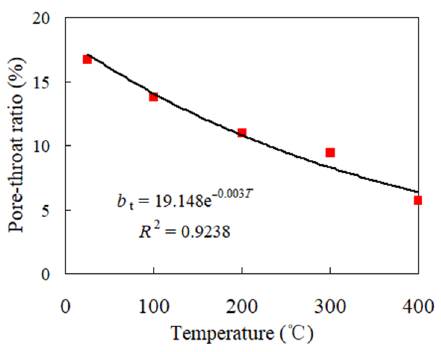
Figure 6. The pore–throat ratio of granite under different temperatures.